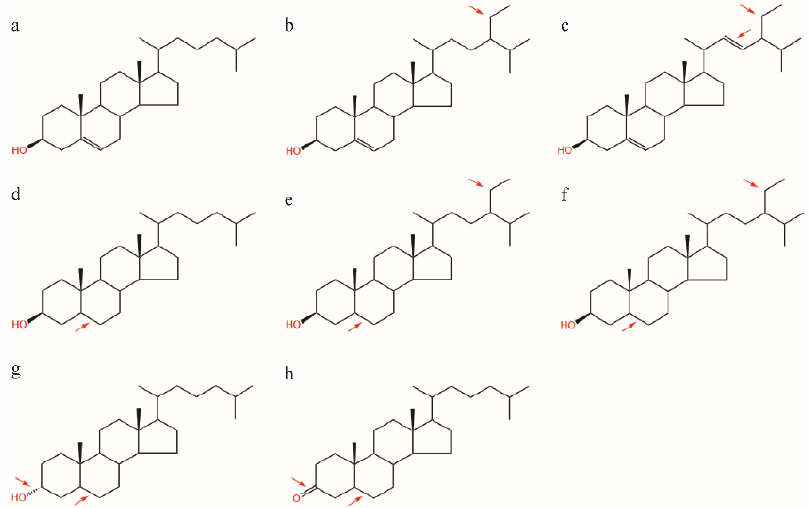
Figure 1. Chemical structure of sterols/steroids in this study. Cholesterol ( a ) is the dominant sterol in most animals; sitosterol ( b ) and stigmasterol ( c ) are the common phytosterols; cholestanol (5 α - 3 β -ol) ( d ), sitostanol ( e ), stigmastanol ( f ), and epi-cholestanol (5 α -3 α -ol) ( g ) are the saturate stanols; cholestanone ( h ) has a ketone group in C3 instead of a hydroxyl and has no ∆ 5 double bond in the sterol nucleus compared with cholesterol. Red arrows indicate the differences between cholesterol and other sterols/steroids.